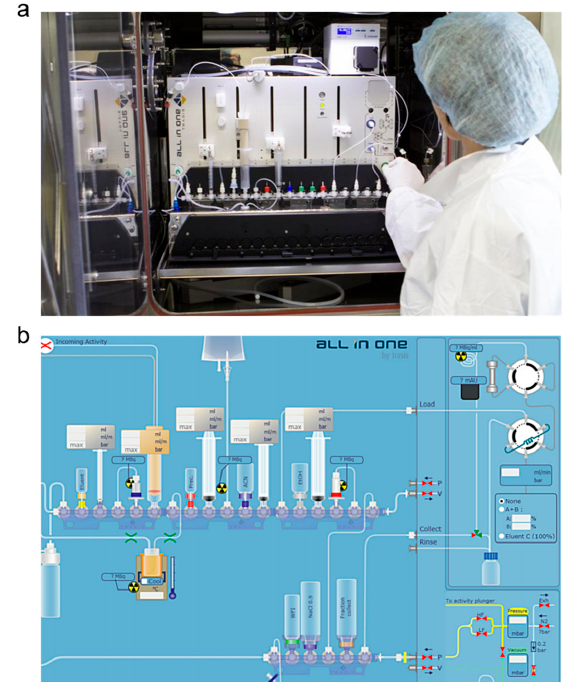
Figure 9. Radiopharmaceutical automation. ( a ) Photograph of a radiochemist setting up an automated synthesis module. ( b ) Example of a graphical user interface for radiopharmaceutical synthesis. Images courtesy of Trasis.